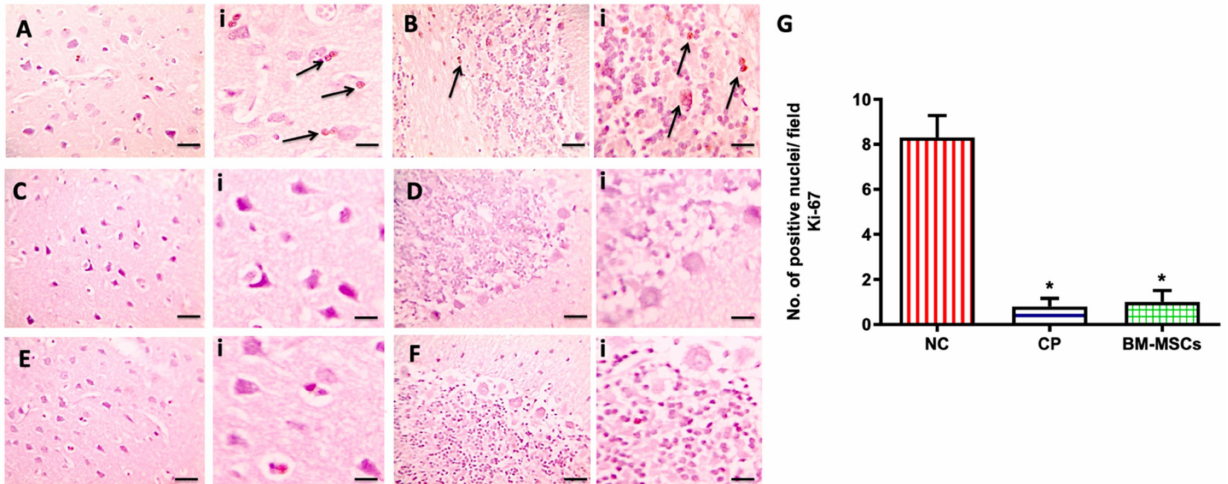
Figure 7. Microscopic pictures of immunostained sections from cerebral cortex ( A ) and cerebellum ( B ) against Ki-67, showing increased positive brown expression in cerebral cortex ( A ) and cerebellum ( B ) from NC group, markedly decreased positive brown expression in cerebral cortex ( C , E ) and cerebellum ( D , F ) from CP and BM-MSCs groups, respectively. Black arrows point to positive staining. The IHC counterstained with Mayer’s hematoxylin. × 400, bar 50 µ m with its corresponding insert (i) × 1000. Statistical analysis of numbers of positive nuclei against Ki-67 in immunostained brain sections ( G ). * p < 0.05 vs. NC group. NC: normal control, CP: cisplatin, BM-MSCs: bone marrow-derived mesenchymal stem